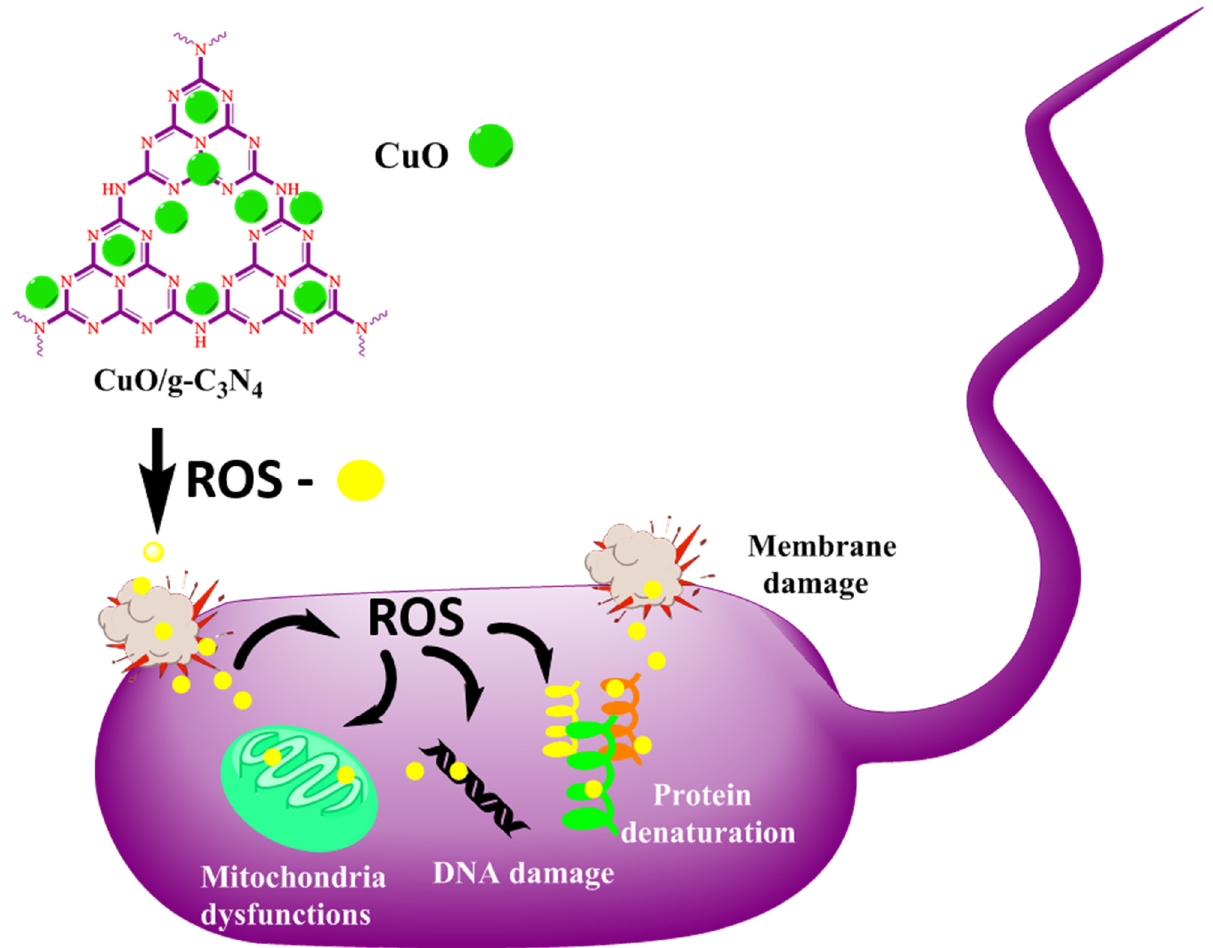
Figure 8. Plausible mechanisms of antimicrobial activity.